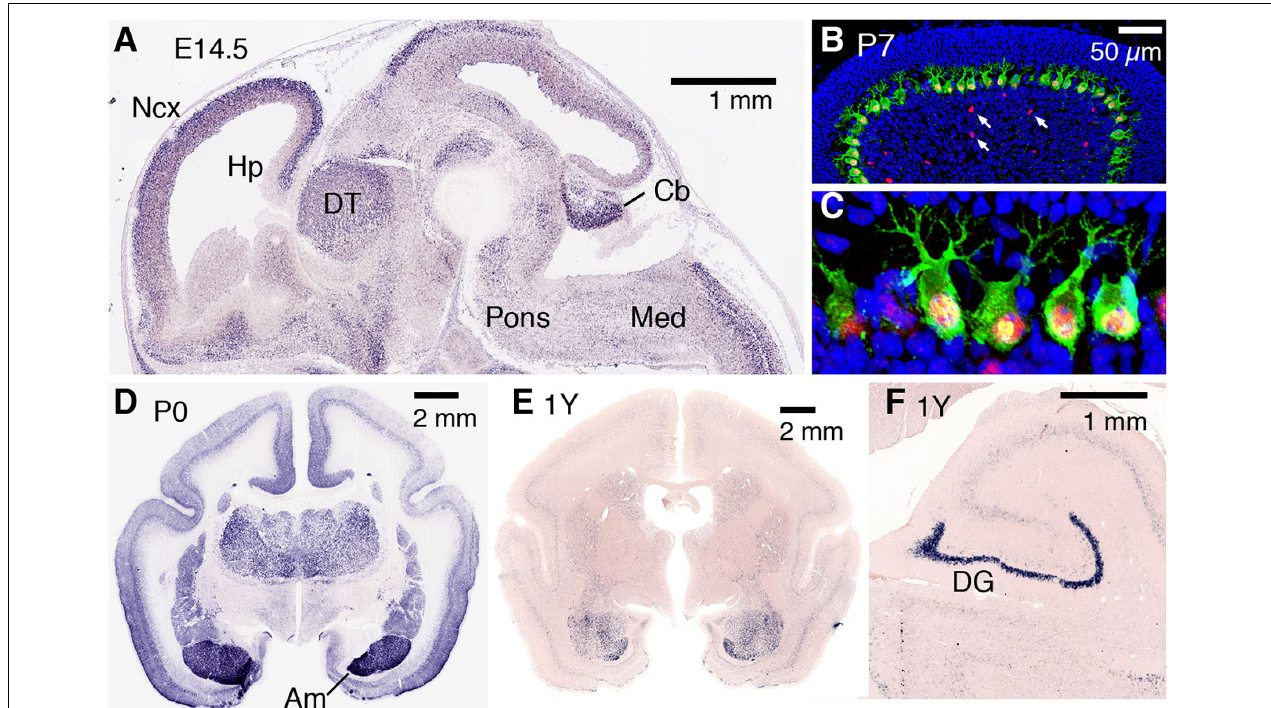
FIGURE 2 | AUTS2 expression in developing mouse and marmoset brain. (A) By in situ hybridization, Auts2 expression is observed in multiple areas of E14.5 mouse brain, including cerebral neocortex (Ncx), hippocampus (Hp), dorsal thalamus (DT), pons, cerebellum (Cb), and medulla (Med). Sagittal section from Genepaint (https://gp3.mpg.de/). (B,C) In P7 mouse cerebellum, AUTS2 protein (red) localizes in the nuclei of calbindin + (green) Purkinje cells, and in scattered Golgi neurons (arrows). Panel (C) magnified 5 × from (B) . (D) In neonatal marmosets, AUTS2 is expressed in many brain regions, with highest levels in amygdala (Am). (E,F) In 1-year-old (young adult) marmosets, AUTS2 levels remain high in amygdala and dentate gyrus (DG). Data for panels (D–F) from the Marmoset Gene Atlas